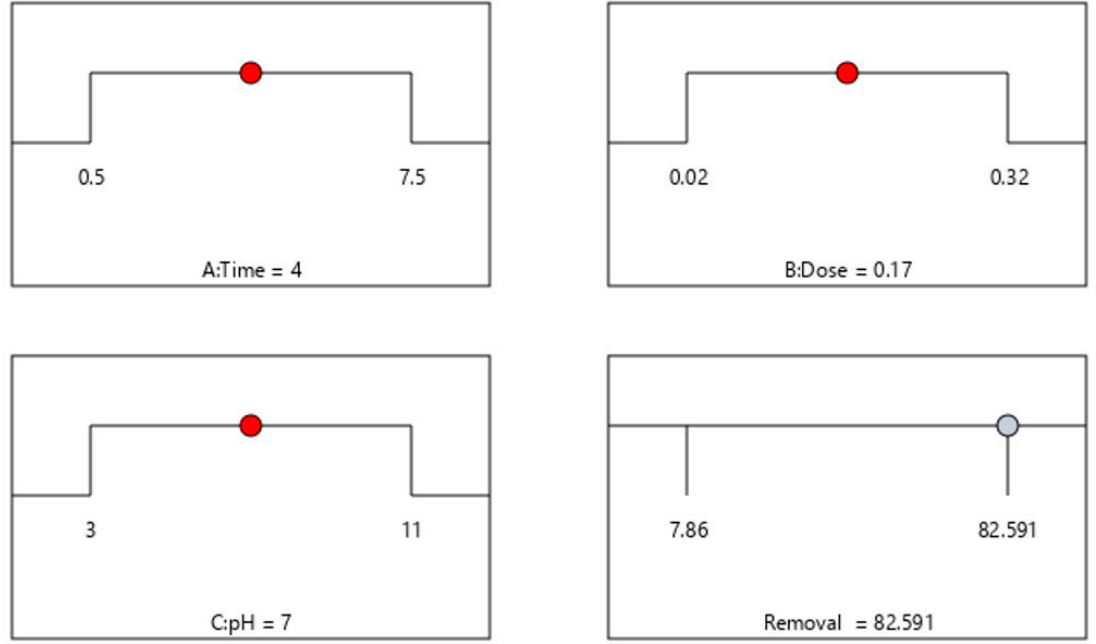
Figure 7. Desirability function-based profile: Optimized values of contact time (4 min), adsorbent dose (0.17 g), pH (7) and maximum % removal of CTM (82.59%).